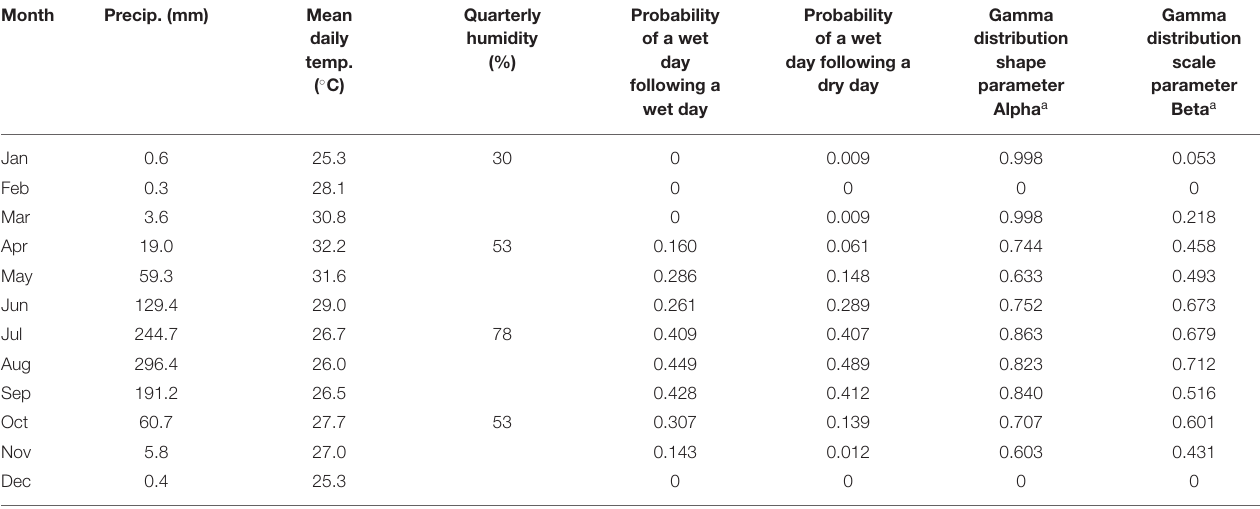
TABLE 2 | Climate parameters used for weather generation.